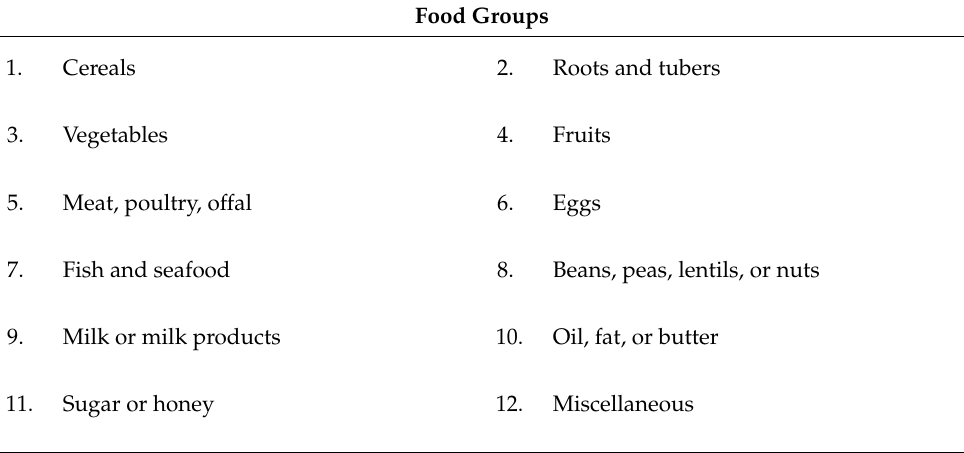
Table 1. Household dietary diversity food groups.